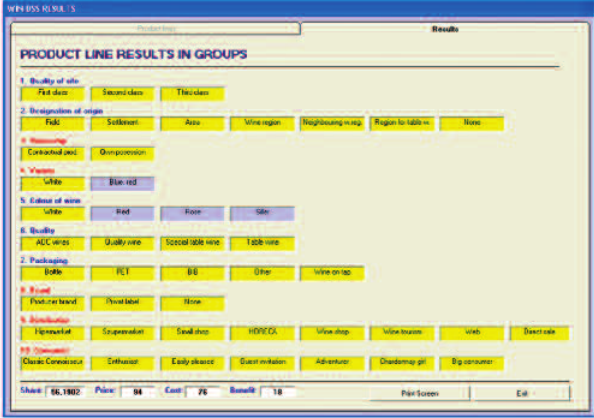
Figure 5 . Evaluation of white vine product